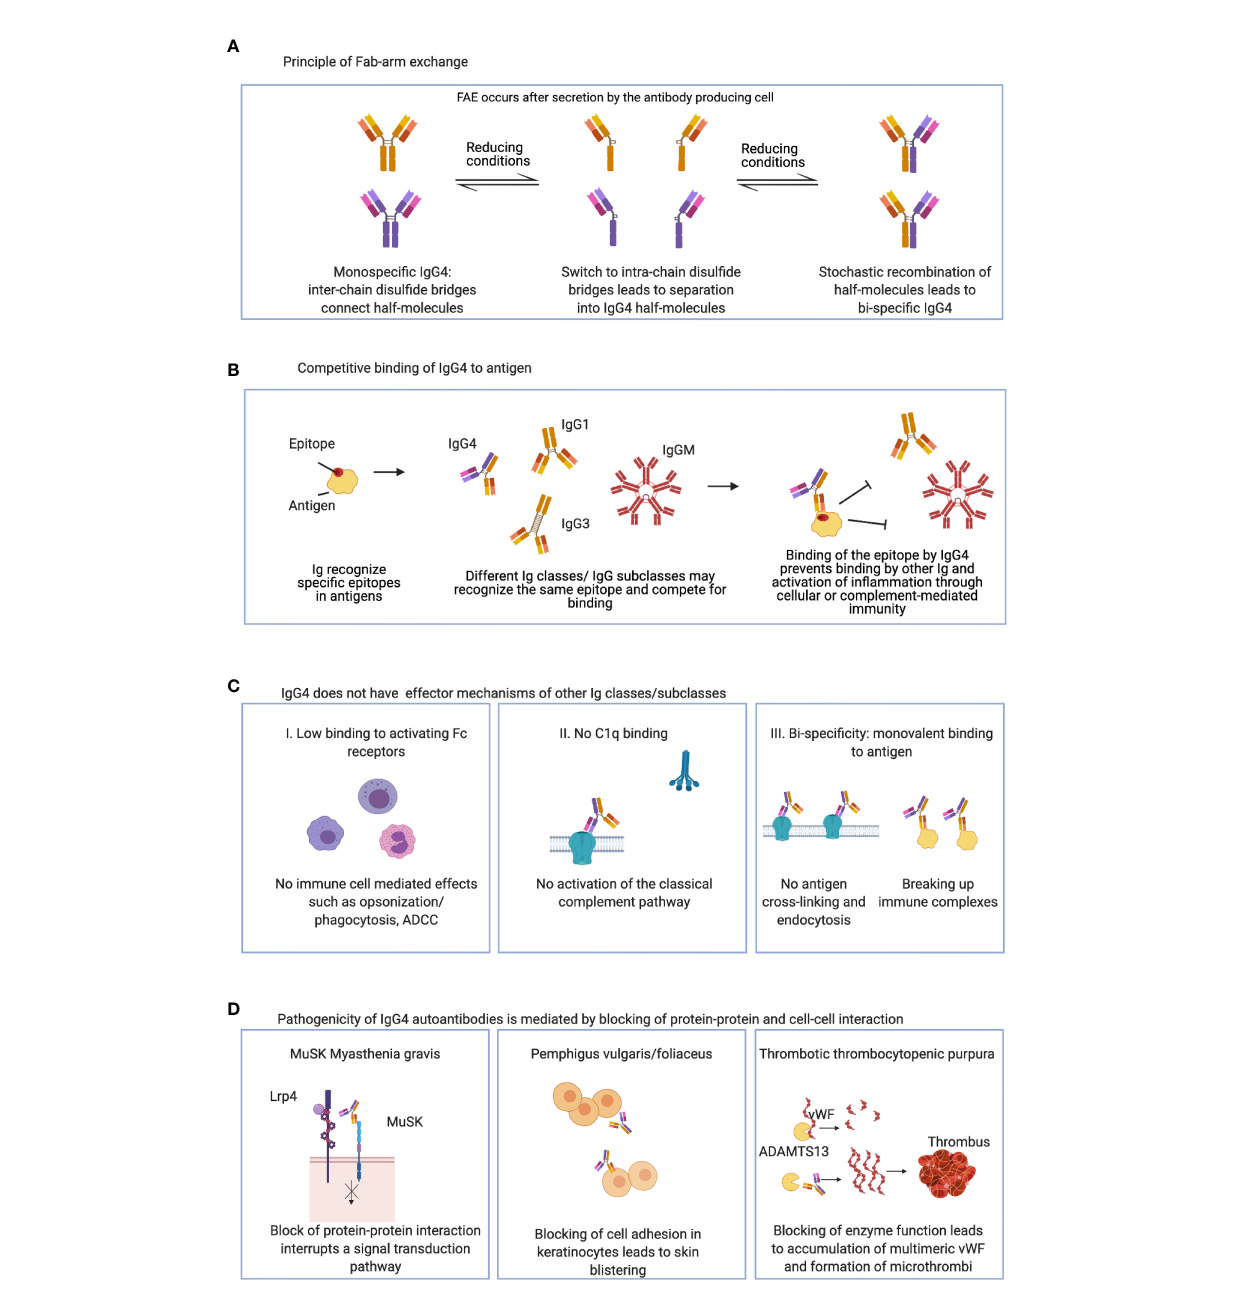
FIGURE 1 | Charactristics of IgG4: (A) IgG4 can undergo Fab-arm exchange and form functionally monovalent antibodies. (B) IgG4 may bind and compete for binding of other Ig classes and IgG subclasses. (C) IgG4 has anti-in fl ammatory properties and lacks typical IgG effector mechanisms. (D) IgG4 autoantibodies can be pathogenic by direct blocking of protein-protein and cell-cell interaction. ADCC, Antibody-dependent cellular cytotoxicity; MuSK, muscle-speci fi c kinase; Lrp4, low density lipoprotein receptor-related protein 4; vWF, von Willebrand factor; ADAMTS13, a disintegrin and metalloprotease with thrombospondin type 1 motif